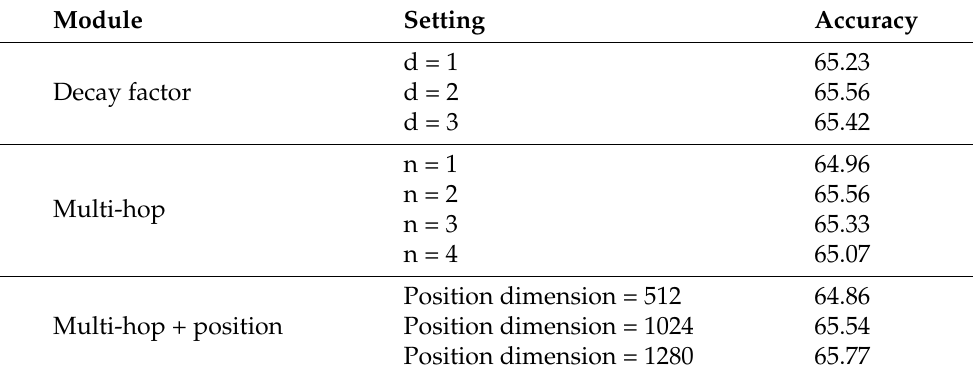
Table 1. Ablation studies of the decay factor, multi-hop layer, and the position embedding. After the model adds position embedding, we verify the model accuracy with the change in the position embedding